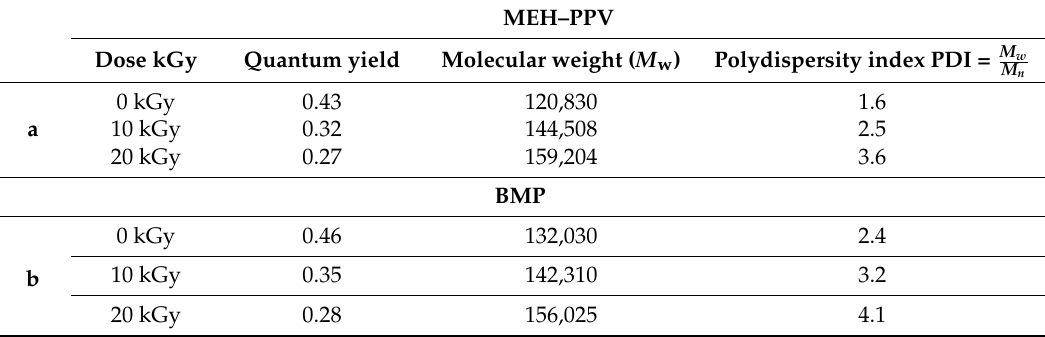
molecular weight and polydispersity of